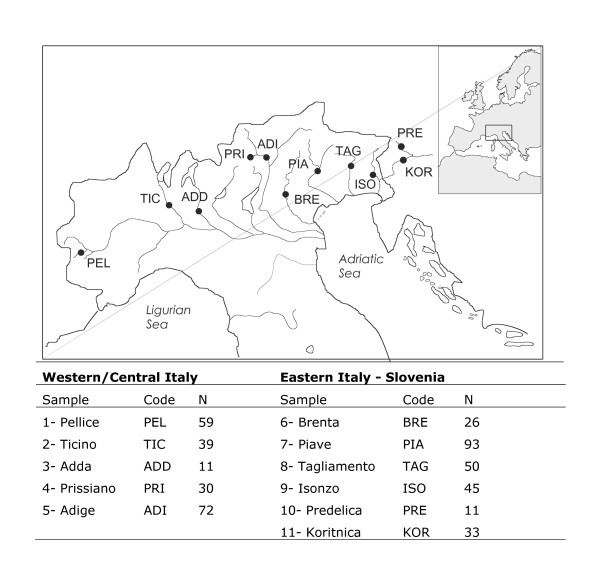
Sampling locations of marble trout.